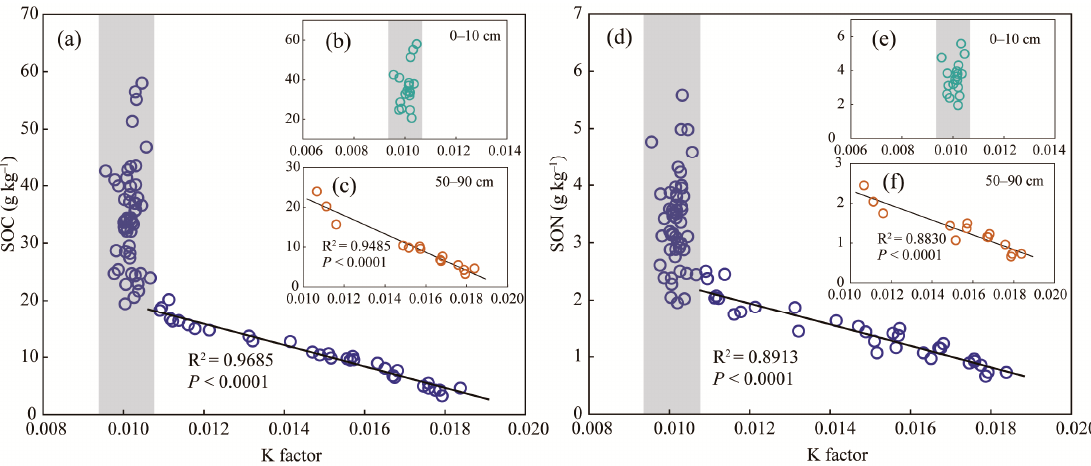
Figure 3. Relationships between K factor and SOC content in soils at all depths ( a ), in soils at 0–10 cm depth ( b ), and in soils at 50–90 cm depth ( c ); and relationships between K factor and SON content in soils at all depths ( d ), in soils at 0–10 cm depth ( e ), and in soils at 50–90 cm depth ( f